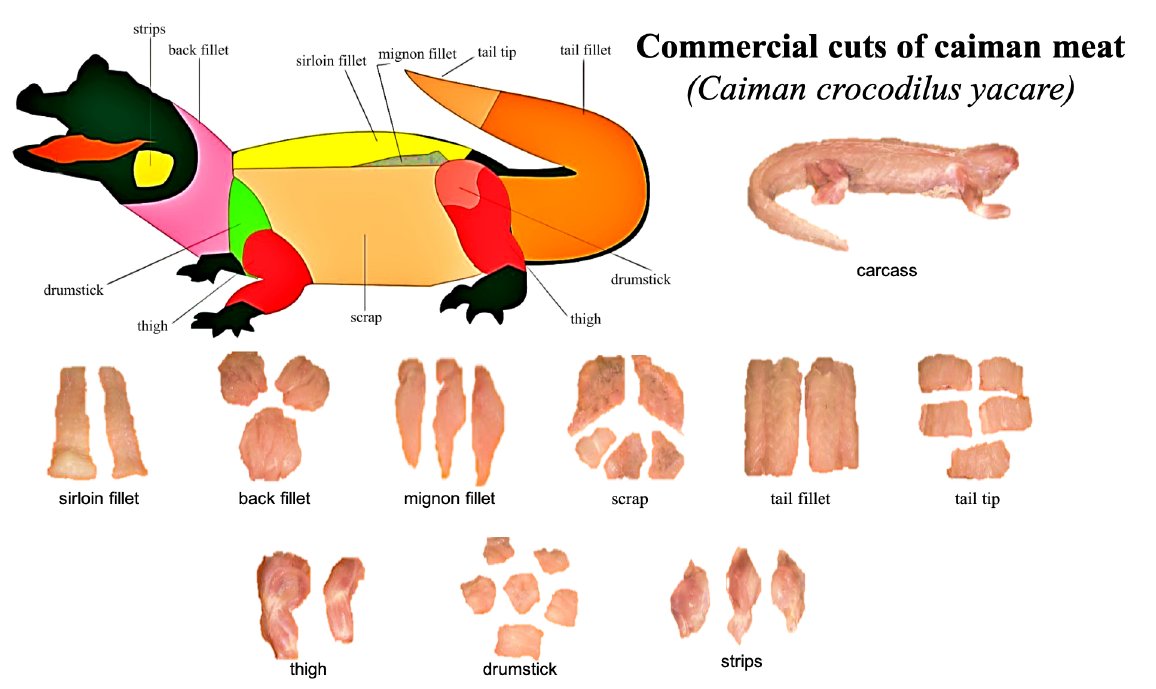
Figure 1. C ommercial cuts of Caiman crocodilus yacare meat developed by the commercial cooperative of caiman farmers ‘Cooperativa dos Criadores de Jacaré do Pantanal – Coocrijapan. Source: COOCRIJAPAN